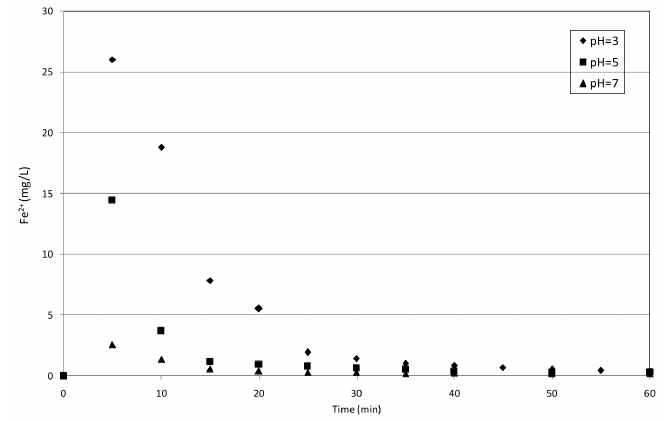
Figure 9. Fe 2+ concentrations detected during the tests conducted with MgO_nZVI and initial Pb 2+ concentration of 30